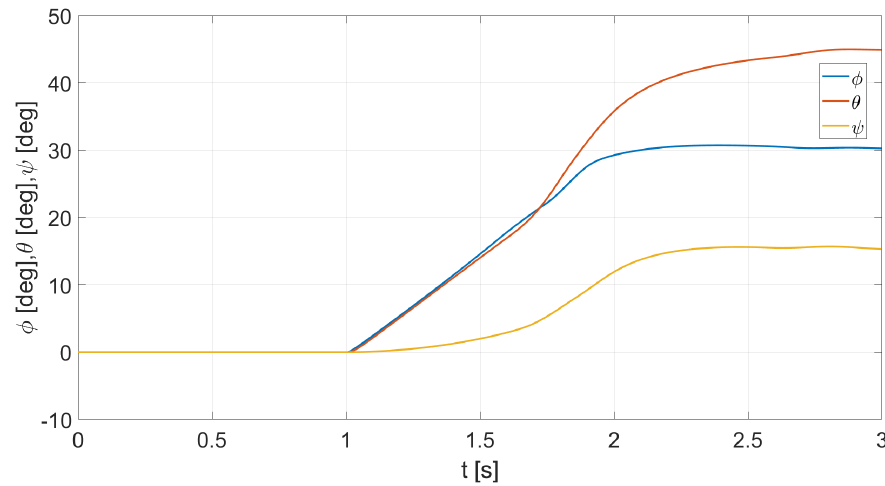
Figure 7. Angular response of UAV—PID-SDRE control mode, t f = 2 s.